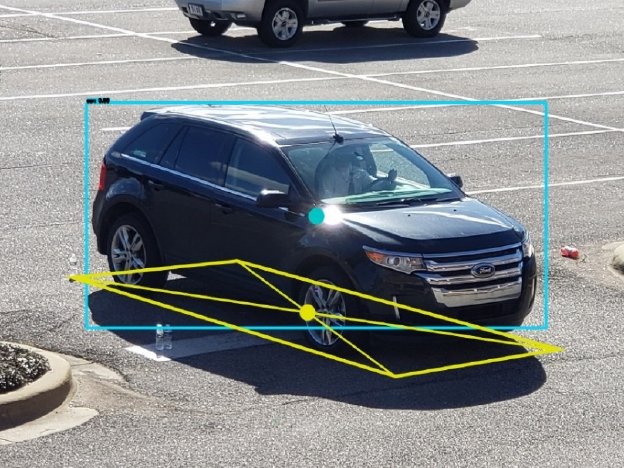
Figure 3 . Error between the center of the bounding box and the true vehicle center . Figure 3. Error between the center of the bounding box and the true vehicle center.